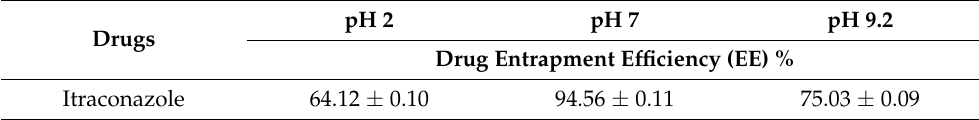
Table 2. Itraconazole drug entrapment efficiency onto synthesized CH-Ag bionanocomposite at different